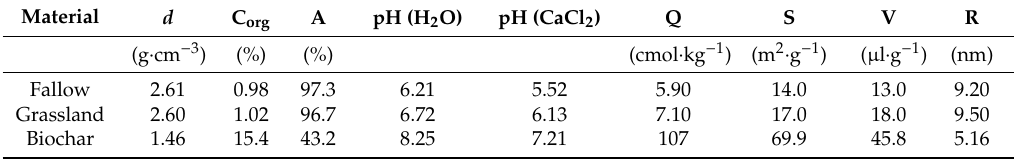
Table 1. Physicochemical characteristics of soils and biochar